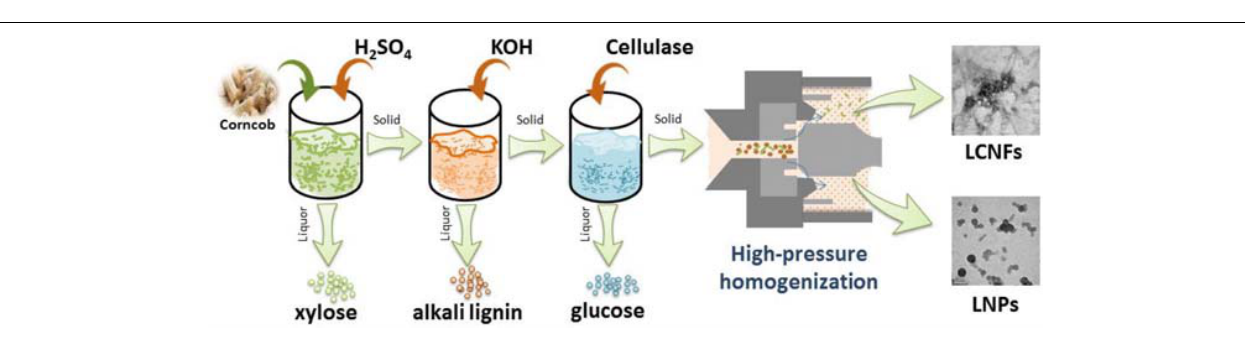
FIGURE 6 | The zeta potential (A) and corresponding dispersibility in water (B) of LCNFs-48 h (i), LCNFs-72 h (ii), and LNPs-108 h (iii).